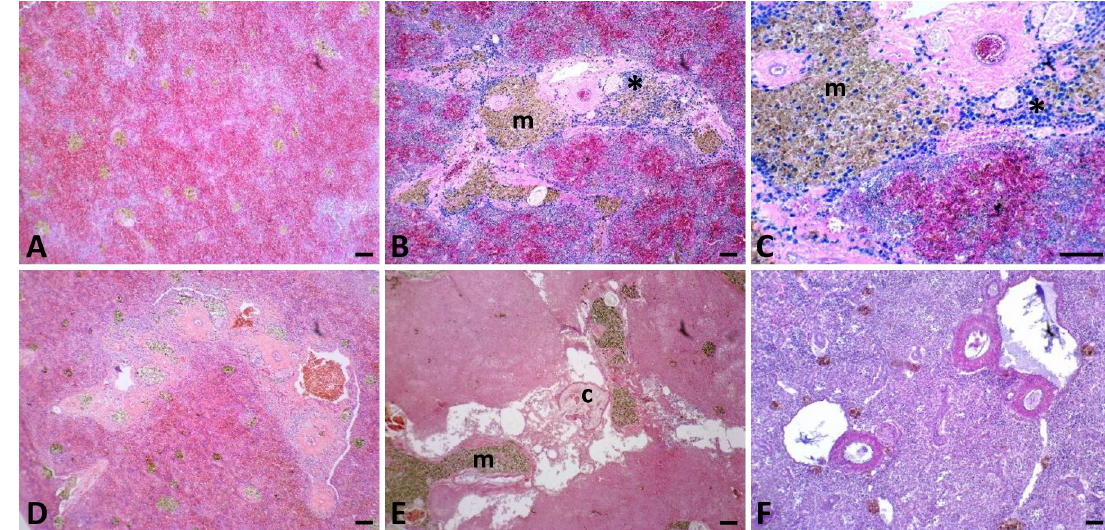
Fig 9. Normal and pathologic splenic histology. Normal splenic histology for Oreochromis andersonii (A) followed by representative splenic inflammatory pathologies observed in three species of Okavango cichlids. Sections shown are from Oreochromis andersonii (B-E) and Coptodon rendalli (F), including sequentially magnified images of the same histological section (B, C). Inflammation was characterized by varying degrees of granulocytic infiltration ( � ), thickened blood vessel walls (B-D, F), congested blood vessels (D), fibrosis (B-E), cellular disruption and destruction, vacuolation (E, F), fluid-filled cysts (c) (E), and increased number and size of melanomacrophages (m) (B-F). All scale bars are 100 μ m. Higher resolution images are available in S5 Fig.